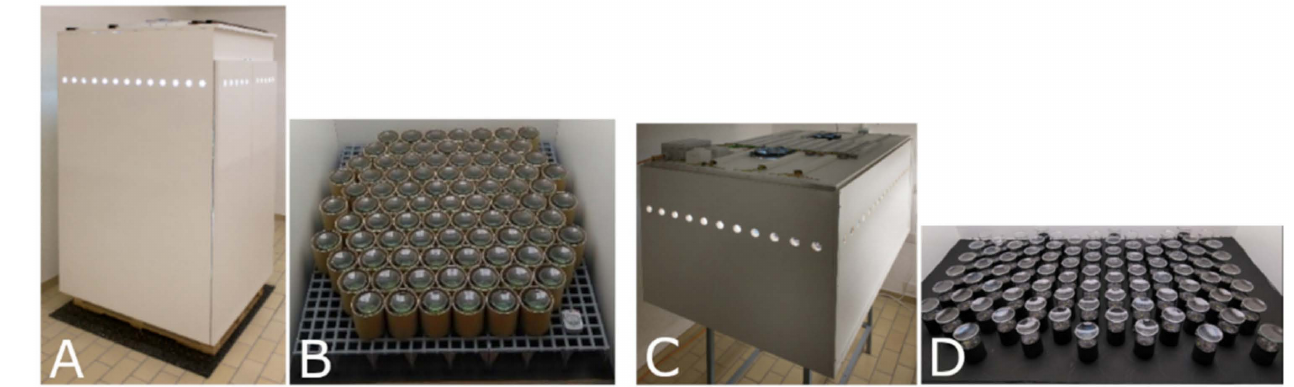
Figure 1. Growth chambers. ( A ) Chamber 1; ( B ) experimental field of chamber 1; ( C ) Chamber 2; ( D ) experimental field of chamber 2; due to different geometry of chamber 1 and chamber 2, the exper- imental field had to be modified to yield comparable conditions in temperature and air